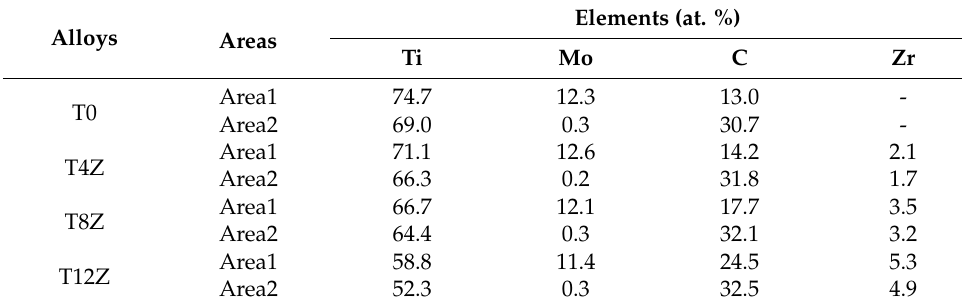
Table 3. The results of EDS elemental analysis for each area in Figure 8.